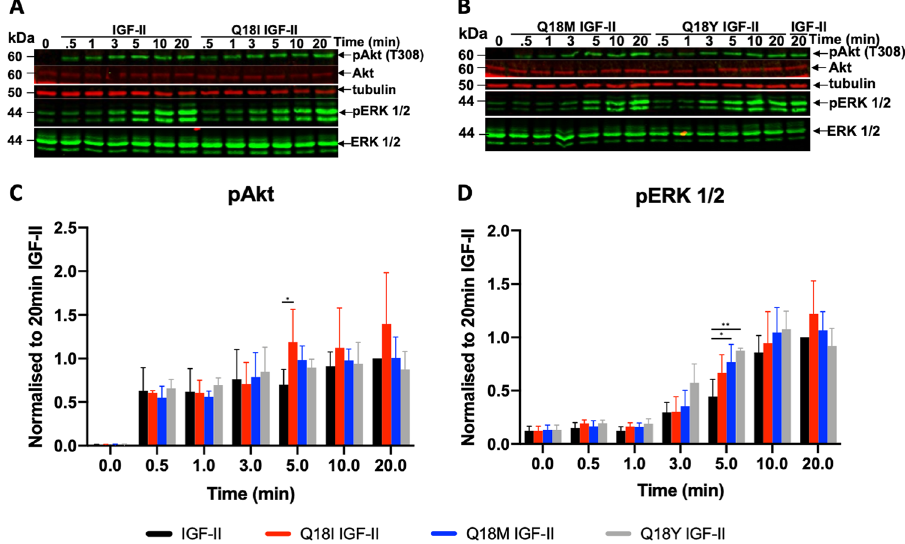
Figure 5. Induction of Akt and ERK phosphorylation upon IR-A activation by IGF-II and Q18 IGF-II analogues. L6 IR-A cells were treated with IGF-II, Q18I IGF-II, Q18M IGF-II, or Q18Y IGF-II at 10 nM for 0, 0.5, 1, 3, 5, 10, 20 min. Whole cell lysates were prepared and subjected to SDS-PAGE followed by immunoblotting for phosphorylated Akt (pAkt), total Akt, phosphorylated ERK 1/2 (pERK 1/2) and total ERK 1/2 ( A , B ). Each blot included lanes from cells untreated (basal = 0 min) and treated with 10 nM IGF-II for 20 min. Densitometric quantitation of n = ≥ 3 independent experiments are shown as a bar graph of the mean ± S.E.M. Relative pAkt ( C ) and pERK ( D ) are expressed as a fraction of the level detected when cells were stimulated with 10 nM IGF-II for 20 min. There is no change in total Akt and ERK 1/2 at these time points. In each case, pAkt and pERK 1/2 was first normalized against the loading control (β-tubulin). Refer to Supplementary Fig. S6 for uncropped Western Blot images. A two-way ANOVA with Dunnett’s multiple comparison was performed. The only significantly different pAkt responses in ( C ) were IGF-II versus Q18I IGF-II at t = 5 min (*p value 0.01 to 0.05). The only significantly different pERK 1/2 responses in ( D ) were at t = 5 min for IGF-II versus Q18M IGF-II (*p value 0.01 to 0.05 and IGF-II versus Q18Y IGF-II **p ≤ 0.01).